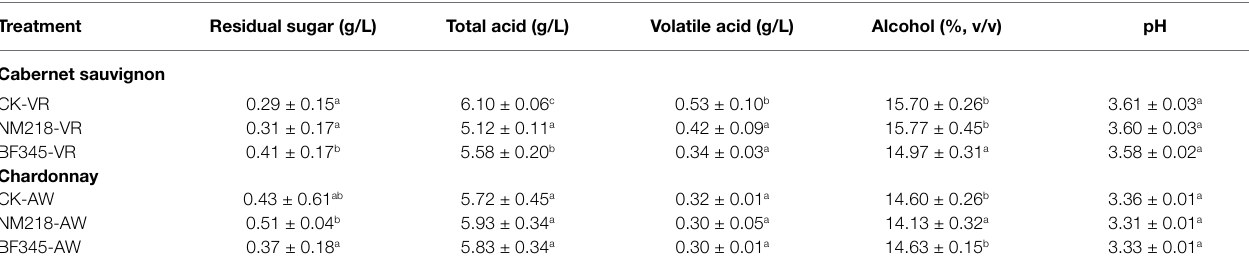
Data are means ± standard deviation of three replicates. Data with different superscript letters (a,b,c) within each column are significantly different (Duncan tests; P < 0.05). CK-VR; pure culture of S. cerevisiae (VR) used as a control in Cabernet Sauvignon wines, NM218-VR; sequential inoculation of M. guilliermondii NM218 and VR at 48 h in Cabernet Sauvignon wines, BF345-VR; sequential inoculation of H. uvarum BF345 and VR at 24 h in Cabernet Sauvignon wines, CK-AW; pure culture of S. cerevisiae (AW) used as a control in Chardonnay wines, NM218-AW; sequential inoculation of M. guilliermondii NM218 and AW at 48 h in Chardonnay wines, and BF345-AW; sequential inoculation of H. uvarum BF345 and AW at 24 h in Chardonnay